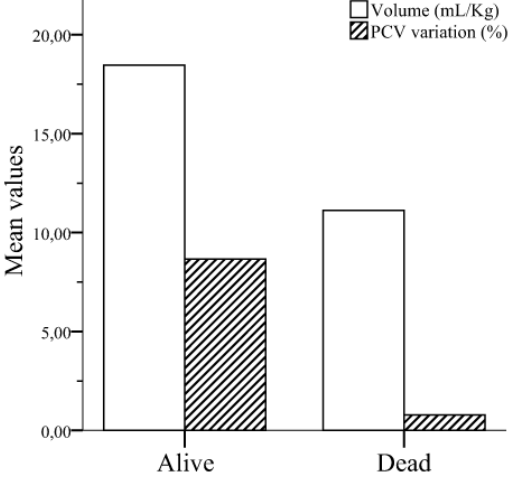
Fig. 4 – Mean transfusion volume (A) and mean PCV variation (B) according to the